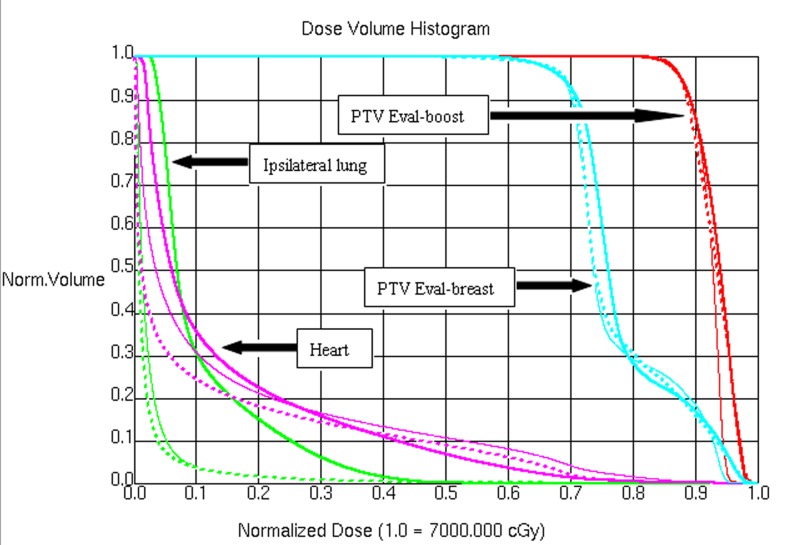
Dose volume histogram of the target volume coverage and normal organs in VMAT (medium solid), IMRT (medium dashed), and IMRT-EB (thin solid).